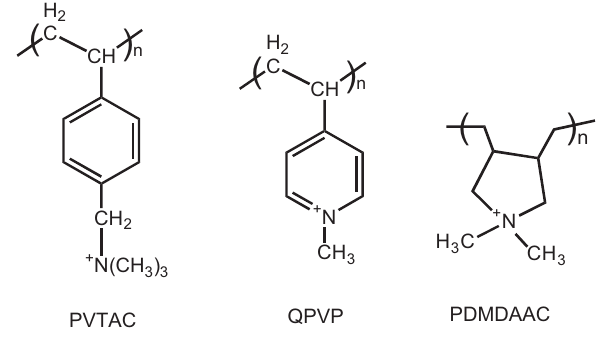
Figure 5 Representative anion exchange polymer